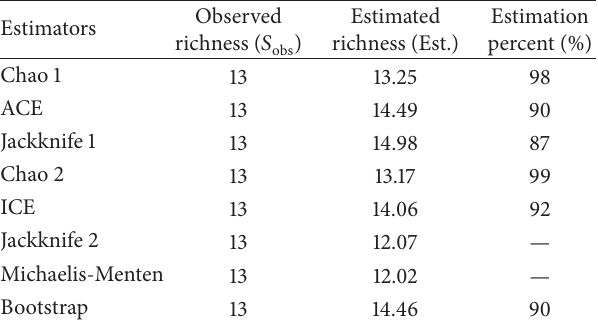
Table 2: Performance of different nonparametric richness estima-